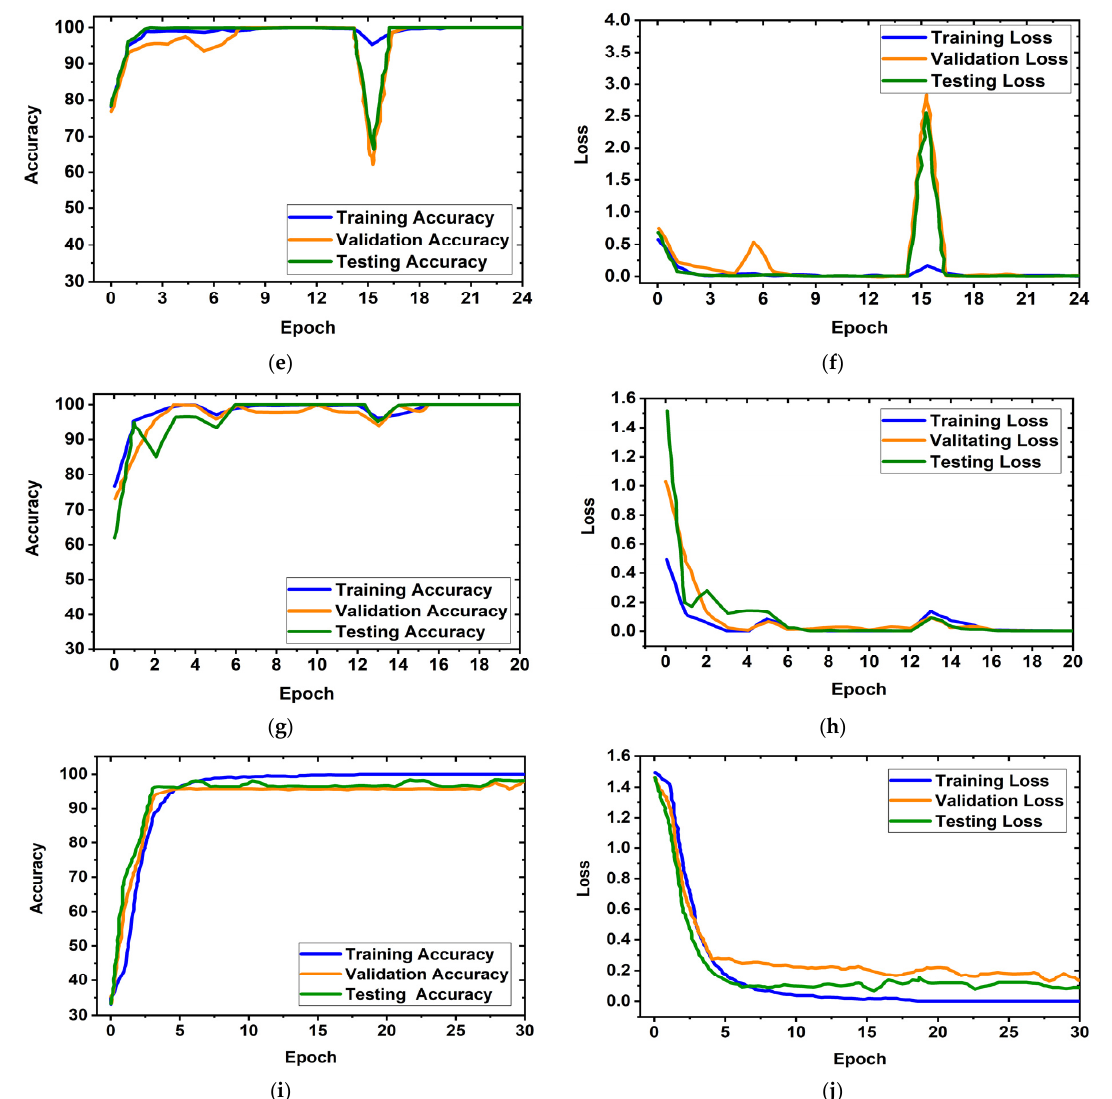
Figure 8. Training, validation, and testing accuracy and loss graphs for five ‐ fold cross ‐ validation dataset: ( a , b ) Fold ‐ 1, ( c , d ) Fold ‐ 2, ( e , f ) Fold ‐ 3, ( g , h ) Fold ‐ 4, ( i , j ) Fold ‐ 5.